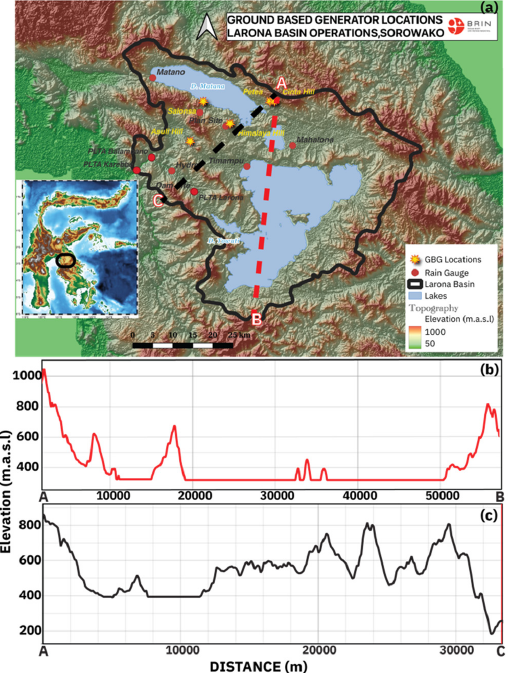
Figure 3. ( a ) A map of the Larona basin within Sulawesi, Indonesia, and the locations of all five GBG towers (yellow stars) and rain-gauge location (red circles); ( b ) topography cross sections of the A–B line (red line in ( a )); and ( c ) topography cross section of the A–D line (black line in ( a )). Table 1. All five towers’ names, coordinates, and heights, from the lowest to the highest, in the Larona Basin, Sorowako, Sulawesi. No. Tower Name Tower Coordinates Tower Height (m.a.s.l.)